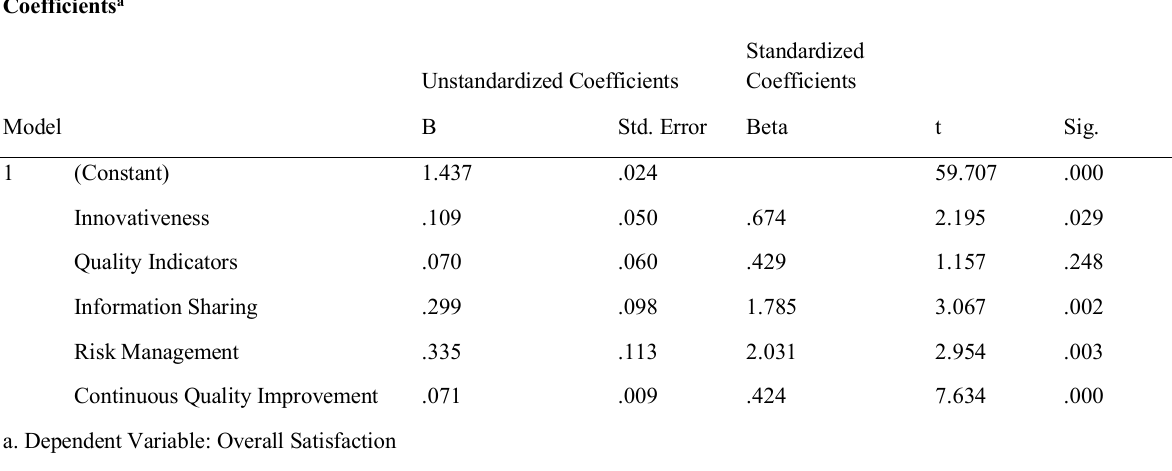
Table 16: Regression coefficients for continuous quality